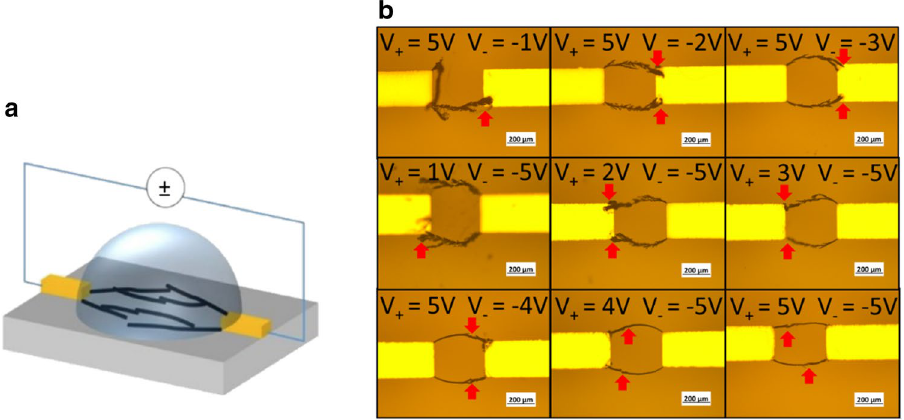
Fig. 2 Direction and dimen- sion of the fibers. a The experimental setup used for the growth process consists of two electrodes, a signal generator, and an electrolyte solution containing EDOT monomers. b The fibers meet in the gap with a symmetry dictated by the shape of the electrical field in the solu- tion. Arrows: contact points between fibers coming from the two